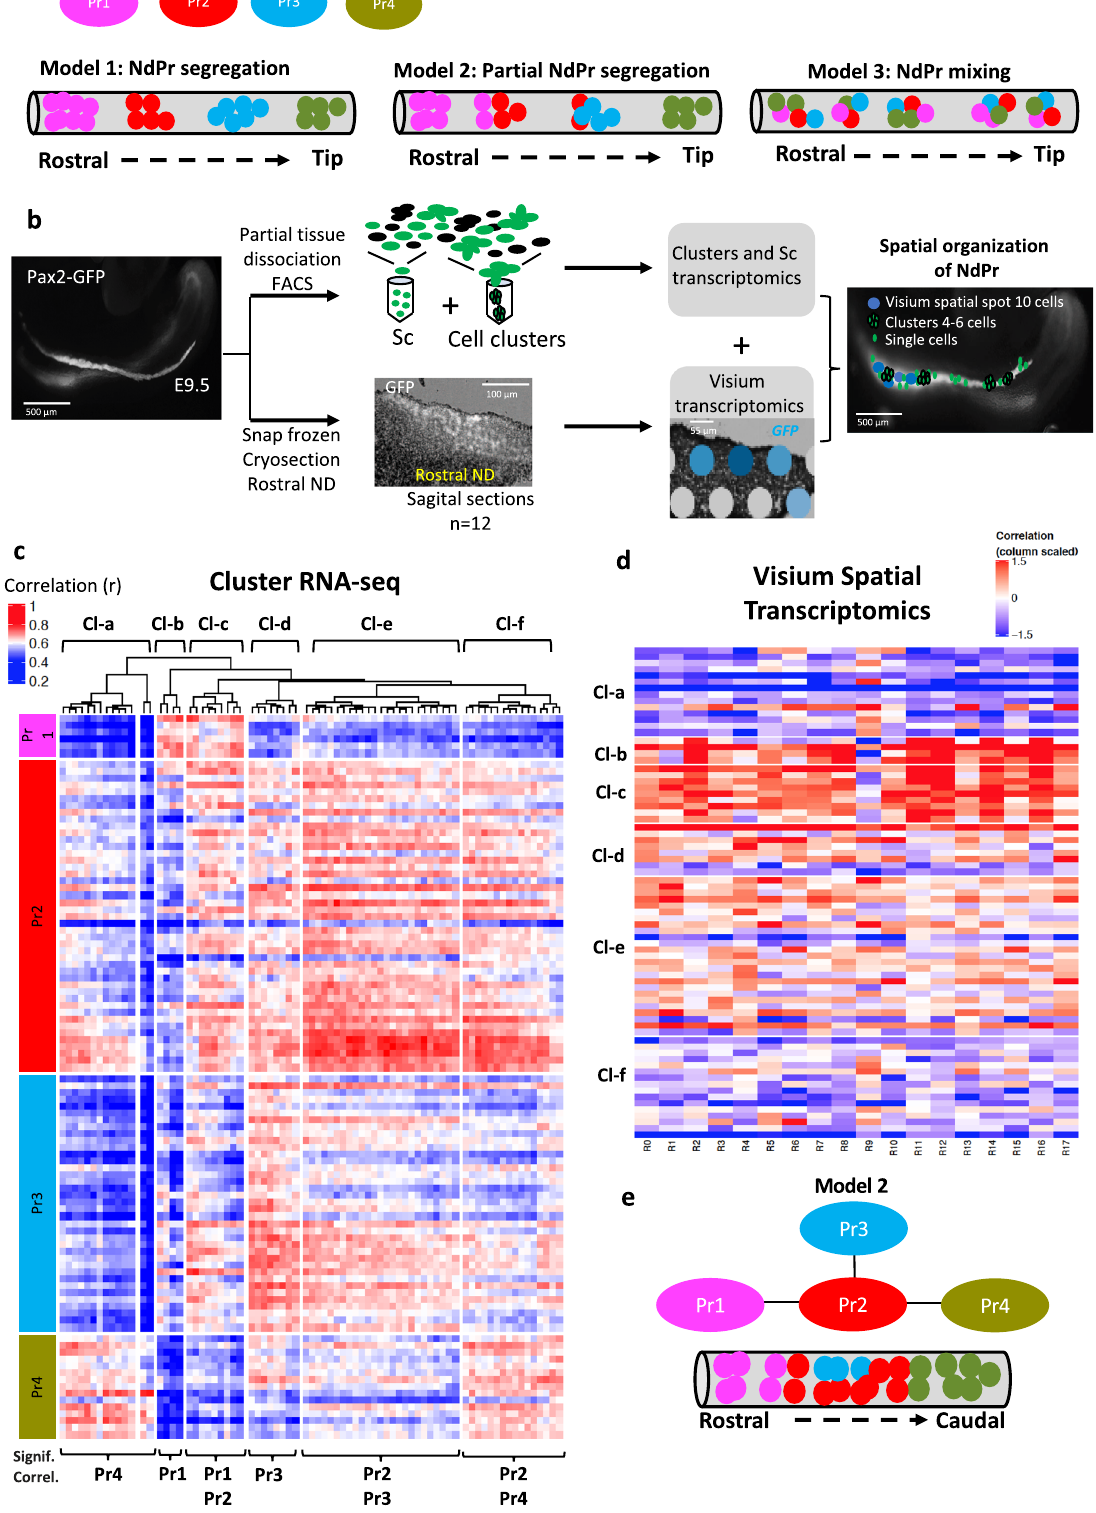
Fig. 3 Cluster-RNA-seq analysis supports the spatial segregation of nephric duct progenitors. a Schematic representation of the nephric duct depicting the spatial location of progenitor (Pr) populations according to three different models. Cell identities are color-coded. b Schematic representation of Cluster RNA-seq and Visium 10× spatial transcriptomics procedures. c Pearson correlation heatmap between Cluster and Single cell libraries, nephric duct lineage only. Single cells are color coded by nephric duct progenitor (NdPr) identity NdPr1, NdPr2, NdPr3 and NdPr4. A summary of the main NdPr identity of Cluster subgroups is shown at the bottom. d Pearson correlation heatmap between nephric duct Rostral spatial and Cluster RNA-seq libraries. e Proposed model for the spatial organization of NdPr in the nephric duct based on the Cluster RNA-seq analysis. Sc: single cell. Cl: cluster.